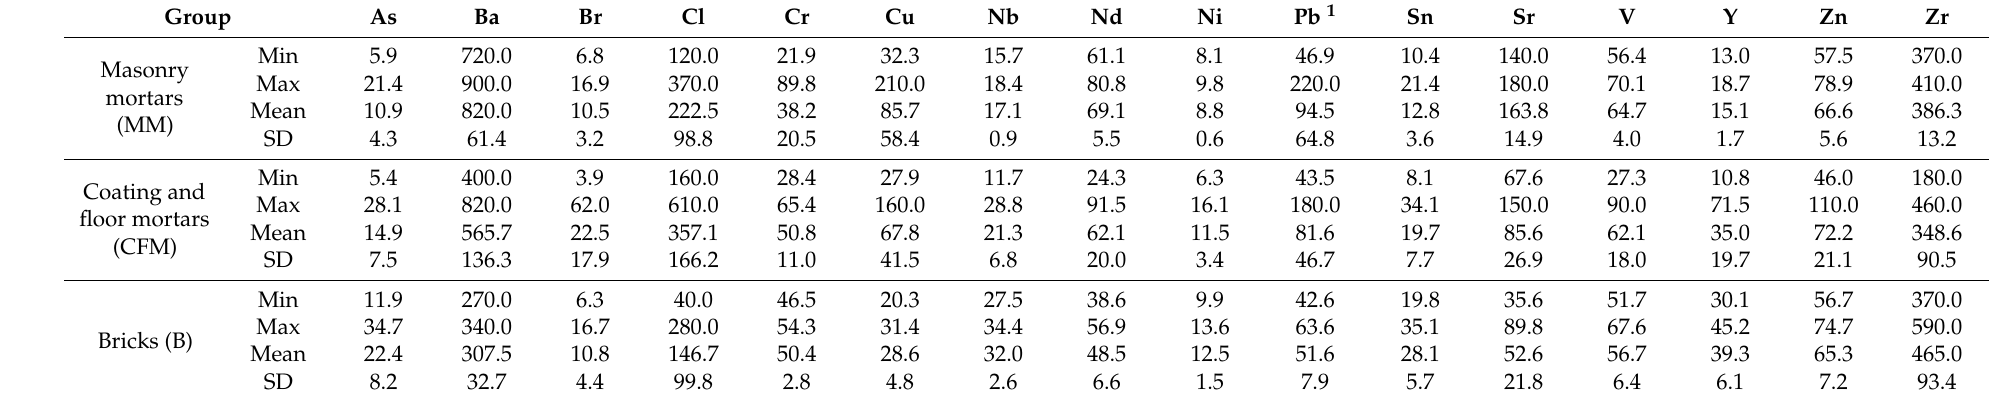
Table 3. Samples trace elements chemical composition, in